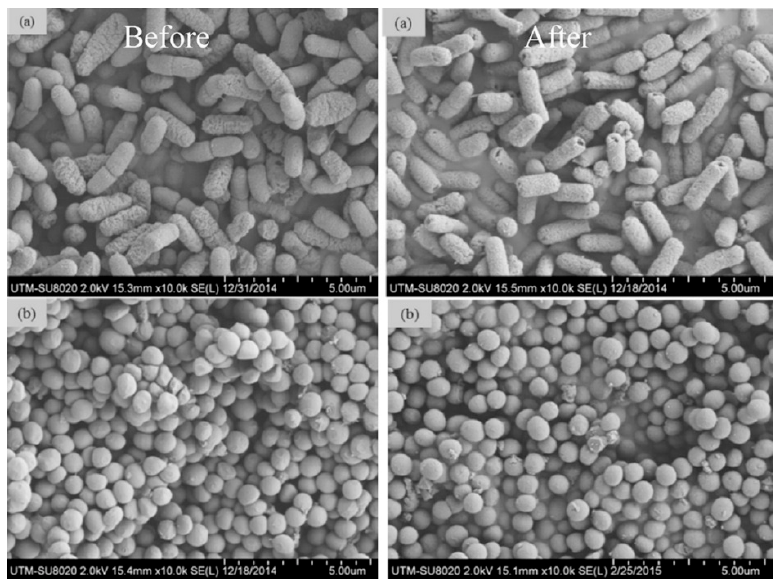
Figure 12. Morphology of ( a ) E. coli and ( b ) S. aureus before and after the antibacterial assay. Reprinted from [133] with permission from Elsevier.